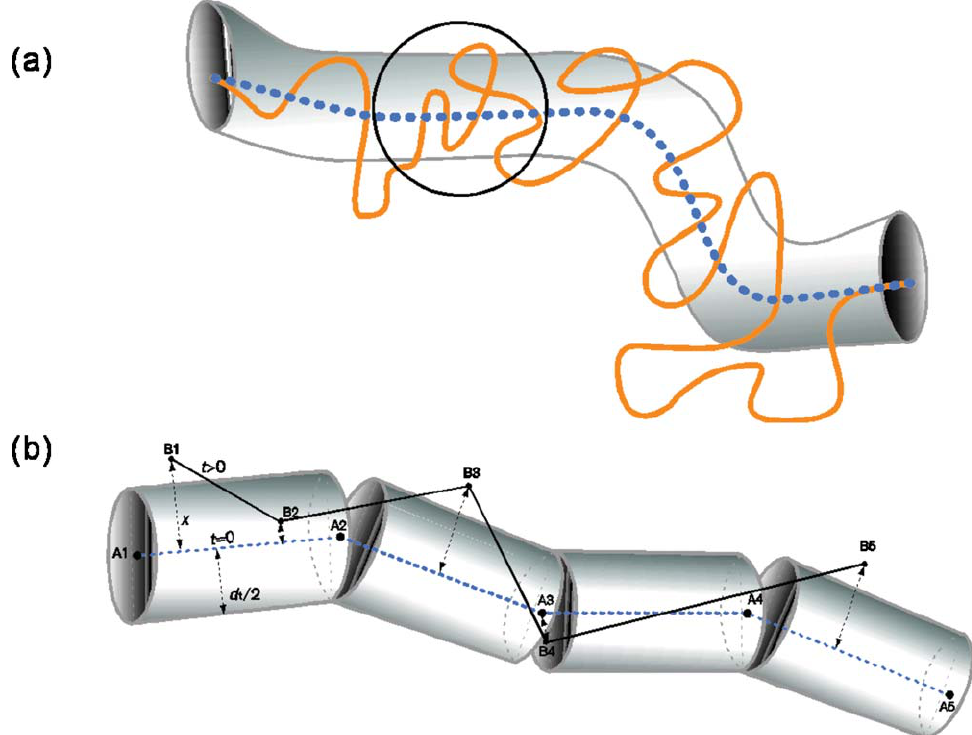
Figure 17. Schematic of tube construction around the primitive path (PP) of a polymer chain to calculate function, ψ ( s, t ) . Figure reproduced with permission from